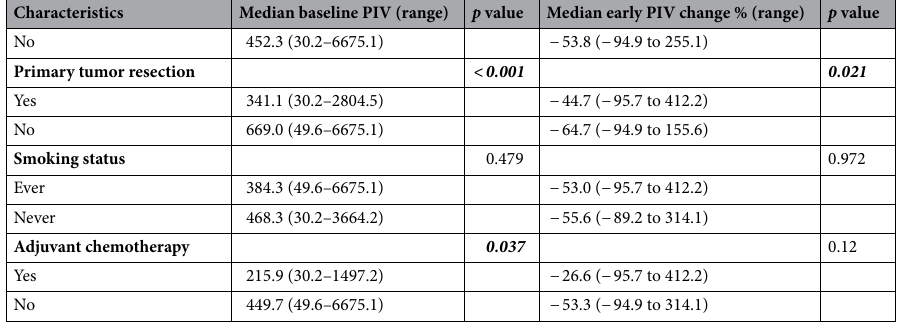
Table 1. Baseline PIV and PIV change according to clinicopathological characteristics. CI confidence interval, CEA carcinoembryonic antigen, BMI body mass index, ECOG‑PS Eastern Cooperative Oncology Group Performance Status, PIV Pan-Immune-Inflammation Value. Bold italics numbers indicate statistically significant